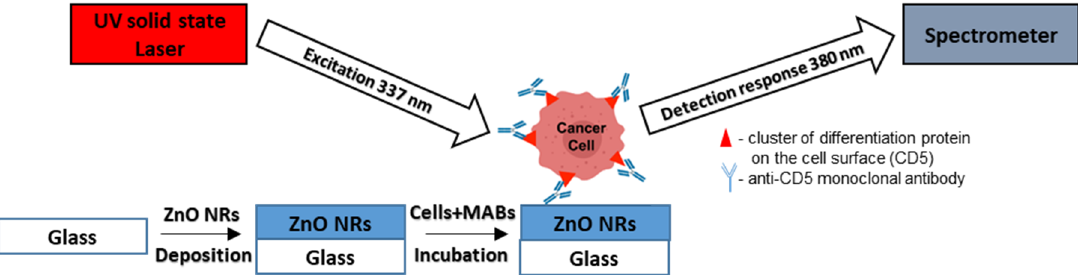
Figure 1. Schematic image of the detection system and the mechanism of T-lymphoblastic cell detection.